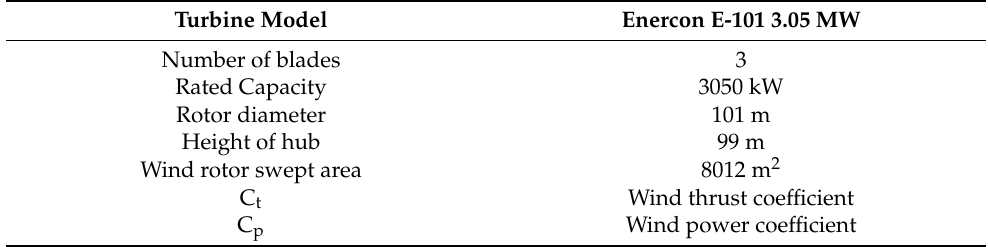
Table 1. Enercon E-101 3 MW unit parameters developed from [11,20].